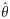
Projection of the phylogeny into thermal sensitivity versus time space.The values of ancestral nodes were estimated from fits of the stable model. Yellow lines represent the median estimates, whereas the 95% credible intervals are shown in red. θ^ is the estimated central tendency for each panel, whereas the existence of a linear trend towards lower/higher values is captured by the reported slope. Parentheses stand for the 95% HPD intervals for θ^ and the slope. All estimates were obtained for ln(E) and ln(Wop), but the parameters are shown here in linear scale. The inset figures show the density distributions of E and Wop values of extant species in the dataset. The arrow in panel D shows an example of a whole clade shifting towards high Wop values, without being attracted back to θ^. The raw data underlying this figure are available at https://doi.org/10.6084/m9.figshare.12816140.v1. HPD, highest posterior density.